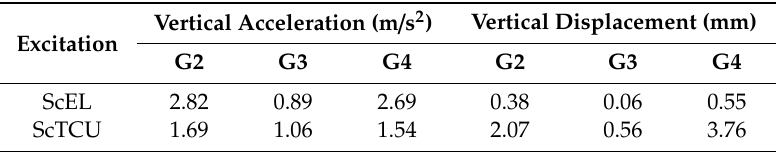
Table 7. The maximum vertical responses of girder.